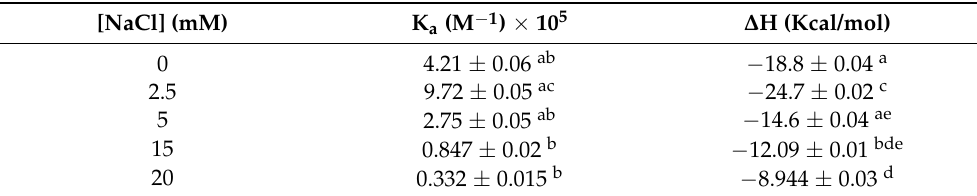
Table 1. The binding constant (K a ) and the enthalpy ( ∆ H) as a function of the salt concentration measured [NaCl] by the GUI of